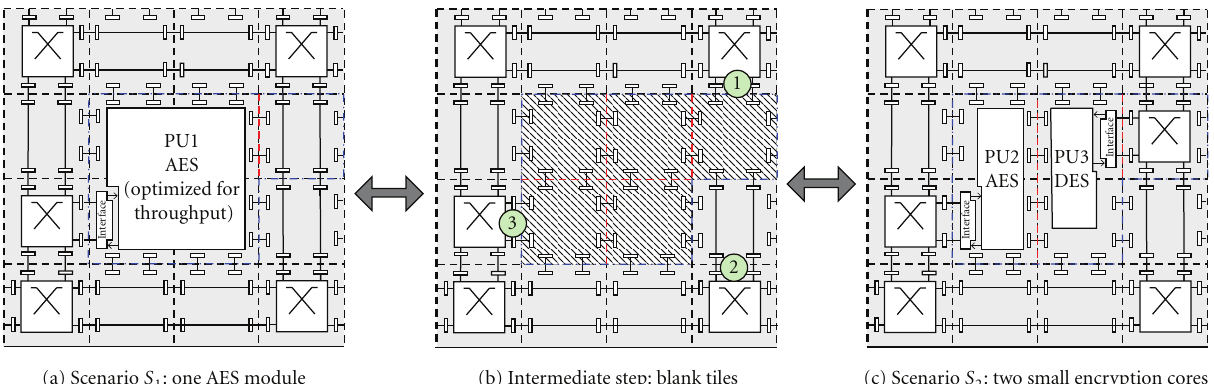
Figure 9: Application example for changing boundaries of PU regions in the context of